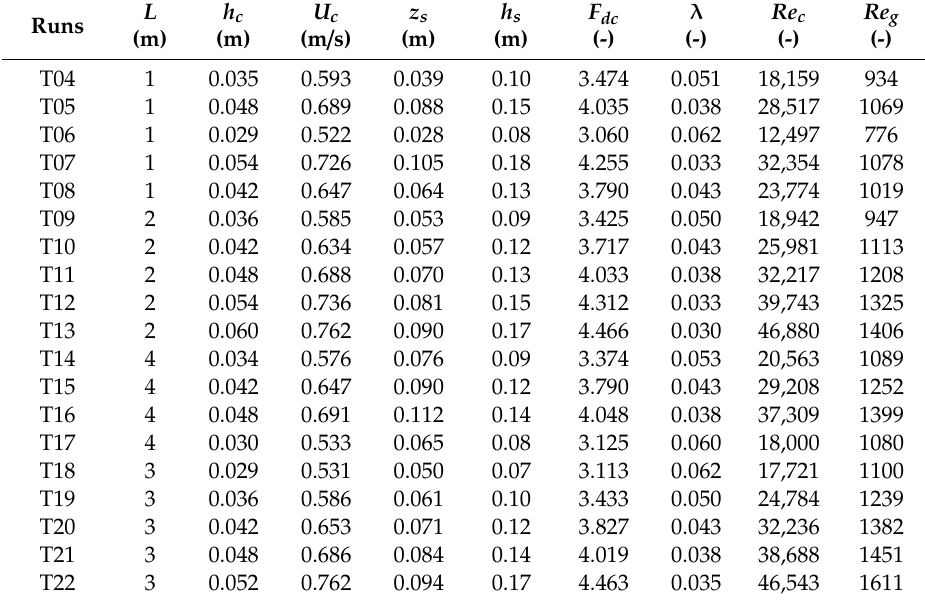
Table 1. Initial experimental conditions and parameters of the investigated